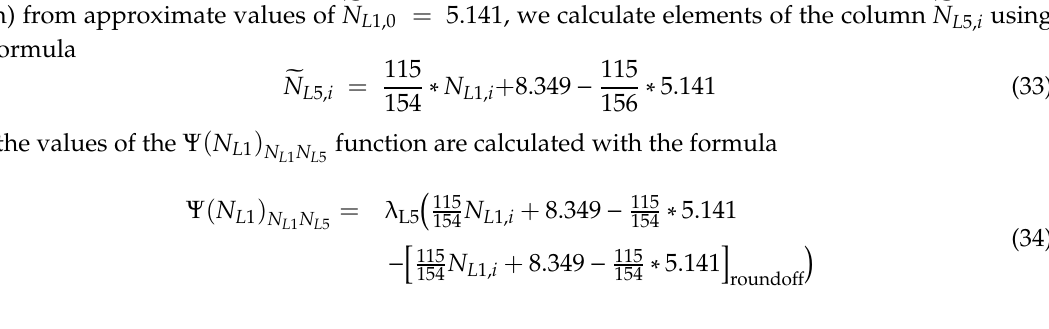
(cid:101) N L 1,0 = 5.141 and N L 1 N L 2 , for